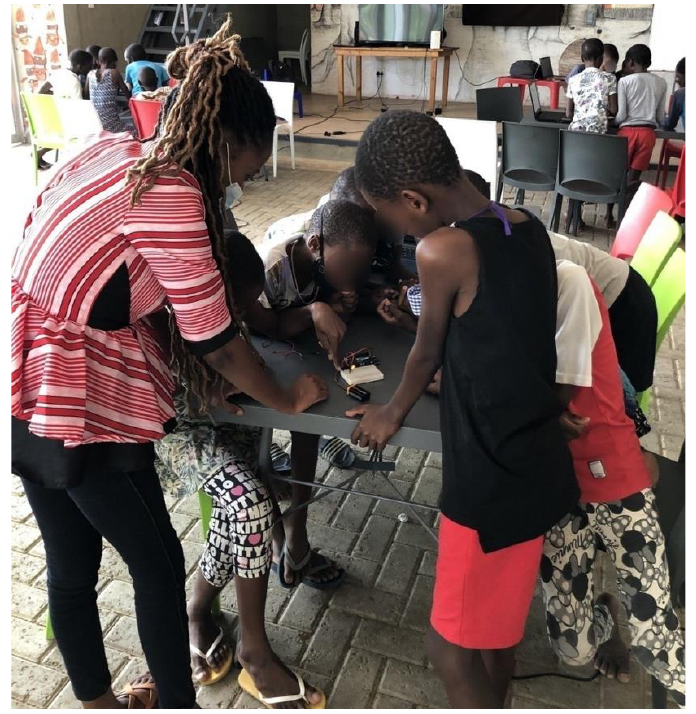
Figure 6. The three teams at the ER workshop.